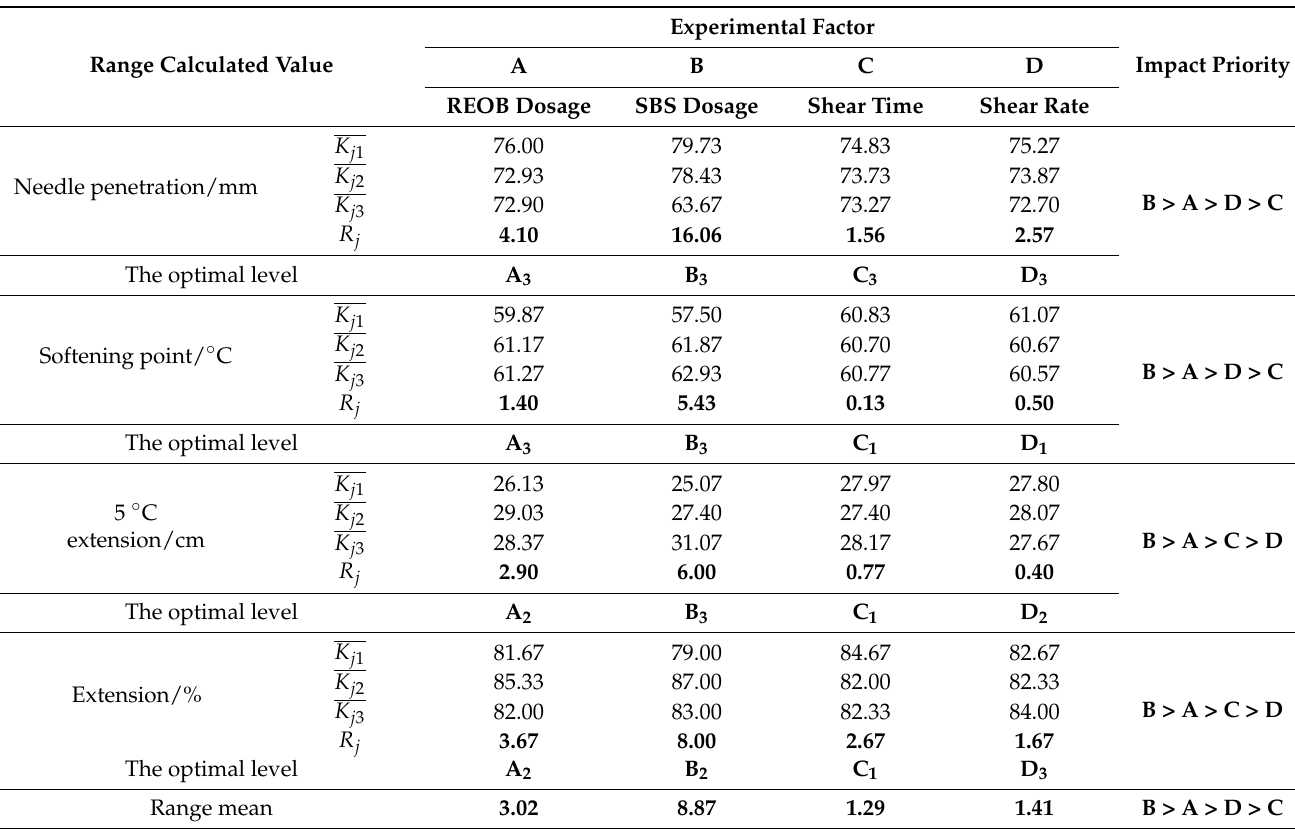
Table 9. Range calculation